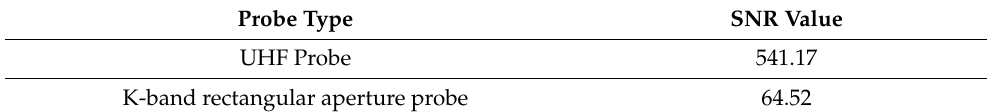
Table 2. The SNR values of damaged patch antenna (mesh)